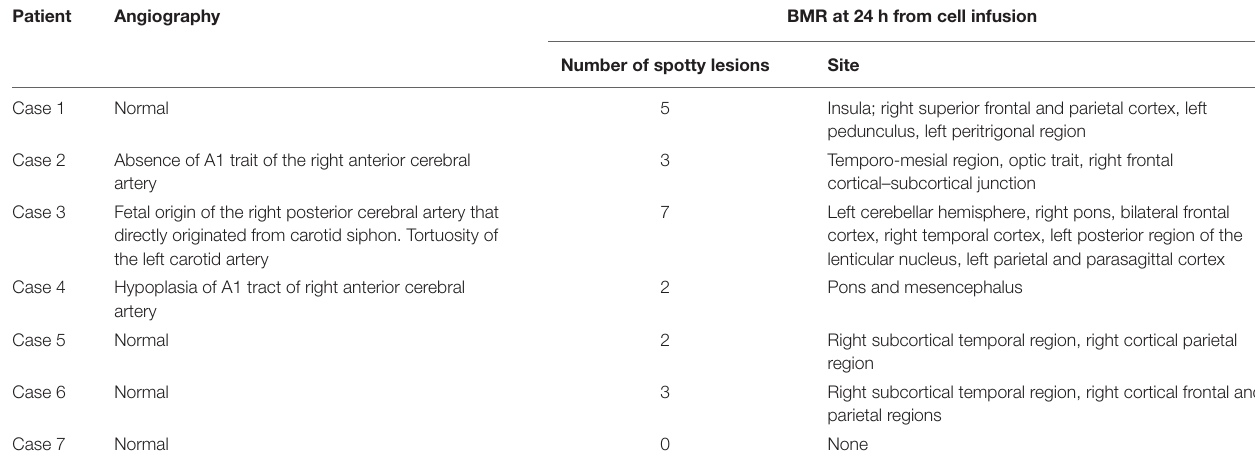
TABLE 2 | Angiographic and post-infusion BMR data ( n = 7).